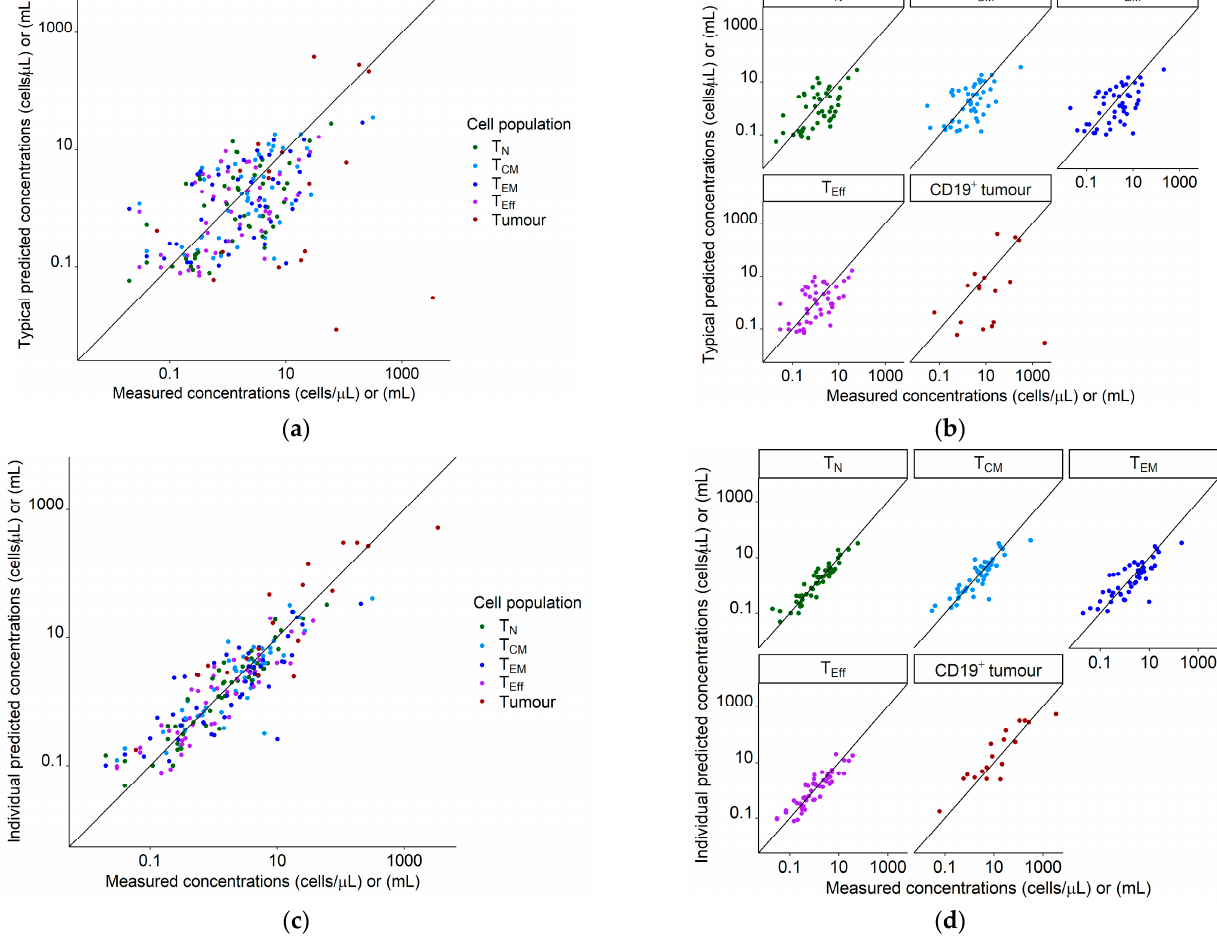
Figure 2. Goodness of fit plots for the population quantitative systems pharmacology model using our clinical dataset of 19 patients. Legend: ( a ) Typical predictions (not considering interindividual variability) vs. measured concentra- tions/volumes for all species; ( b ) typical predictions (not considering interindividual variability) vs. measured concentra- tions/volumes, stratified for species; ( c ) individual predictions vs. measured concentrations for all species; ( d ) individual predictions vs. measured concentrations, stratified for species. Diagonal line: Line of identity. Tumor measurements marked as a complete response were set to a value of 0 mL and are not shown. Abbreviations—T N : naïve T cells, T CM : central memory T cells, T EM : effector memory T cells, T Eff : effector T cells, CD19 + tumor: CD19 + metabolic tumor